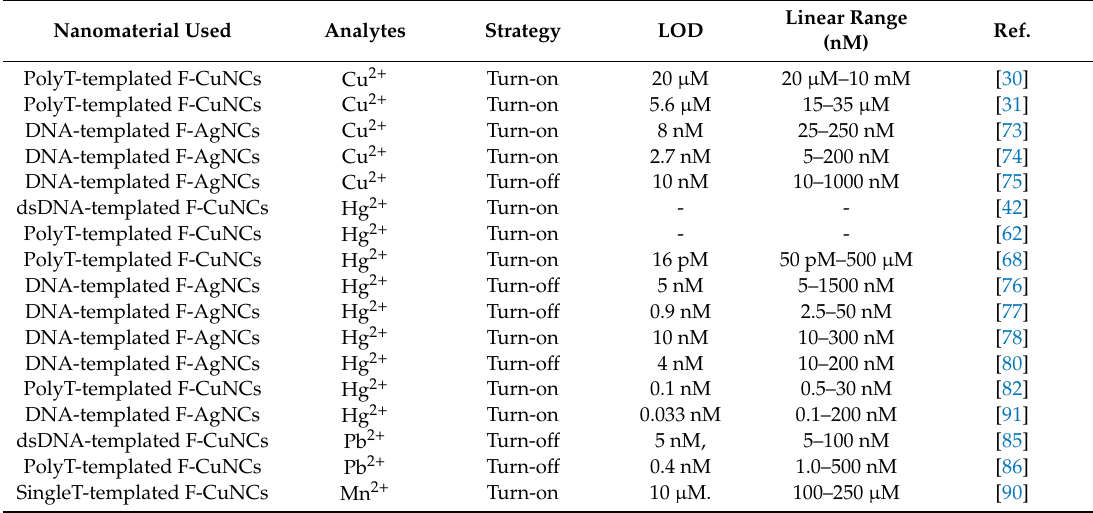
Figure 8. Schematic representation for ( A ) Turn-o ff sensing of Hg 2 + based on dsDNA-templated F-CuNCs. Reprinted with permission from Ref. [85]. Copyright 2012, Royal Society of Chemistry; ( B ) PolyT-templated F-CuNCs based turn-o ff sensing of Hg 2 + . Reprinted with permission from Ref. [86]. Copyright 2014, Japan Society for Analytical Chemistry; ( C ) Turn-o ff detection of Mn 2 + using single T-templated F-CuNCs. Reprinted with permission from Ref. [90]. Copyright 2017, Royal Society of Chemistry. Table 1. Summary of DNA-templated nanoclusters that used for metal ions detection [30,31,42,62,68,